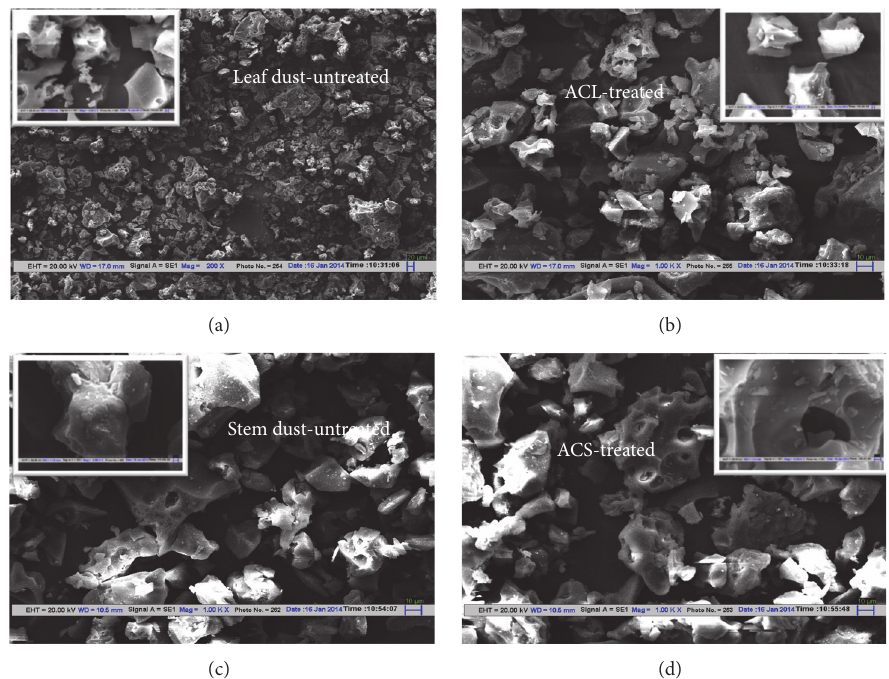
Figure 2: SEM images of different magnification of L. camara (stem and leaves) samples before and after acidic treatment.